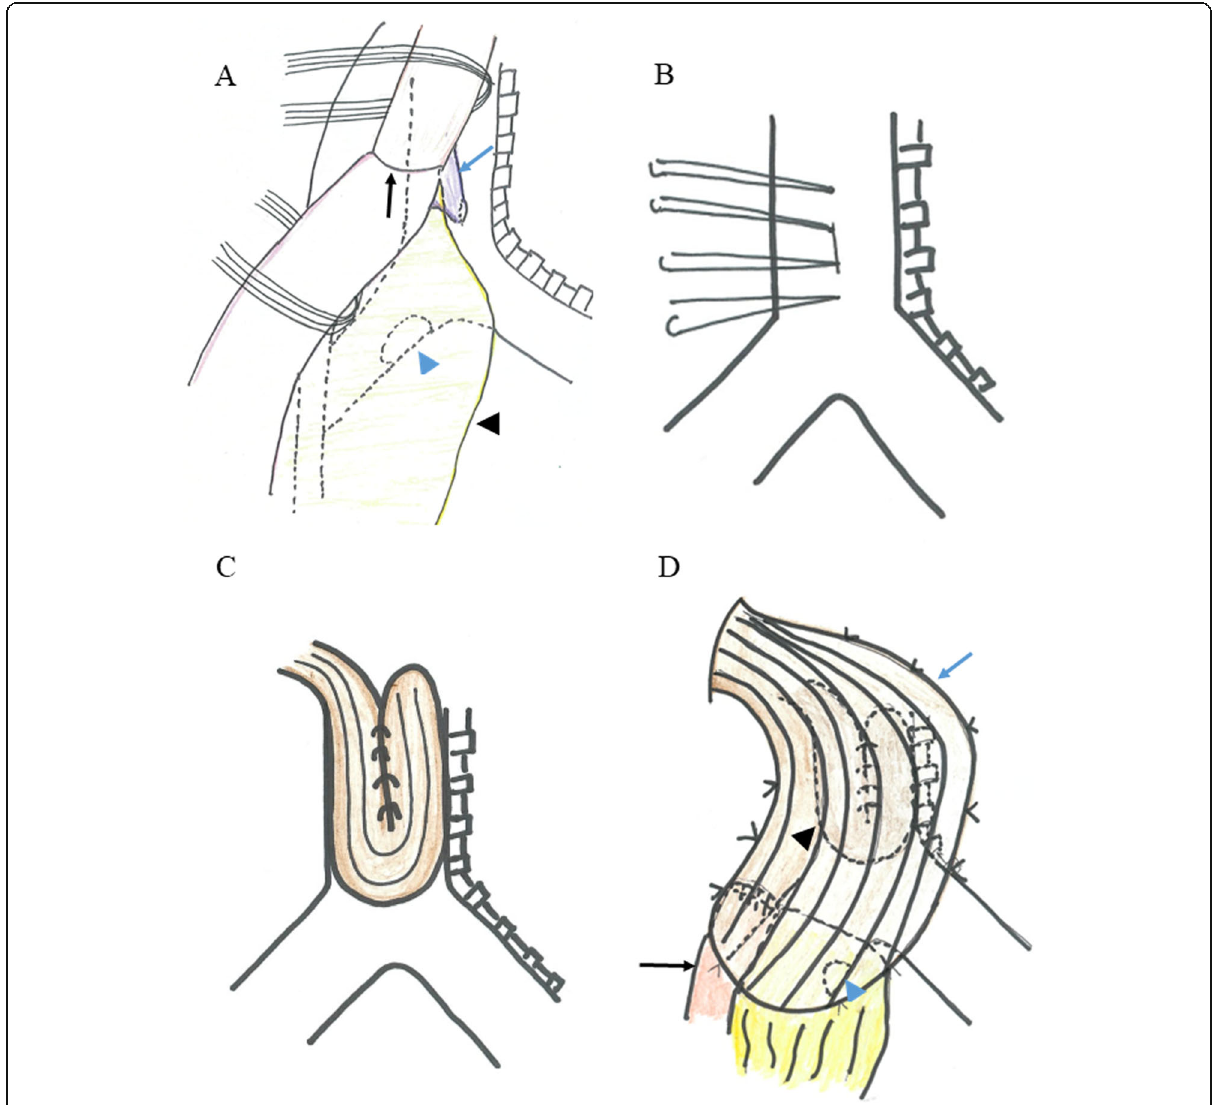
Fig. 4 Schema of operative findings. We found anastomosis and separated from the trachea (black arrow). GTF was visualized between the trachea and the gastric conduit (blue arrow). The left main bronchial fistula was covered with omentum (blue arrowhead). Black arrowhead shows the omentum. This schema is created from Fig. 3a ( a ). We performed direct suture for GTF on the right side at the trachea ( b ). The intercostal muscle was inserted and covered above the sutured portion ( c ). The area including the intercostal muscle flap (black arrowhead) and left main bronchial fistula covered with omentum (blue arrowhead) was widely covered and fixed with this latissimus dorsi muscle flap (blue arrow). Black arrow shows the remnant gastric conduit ( d